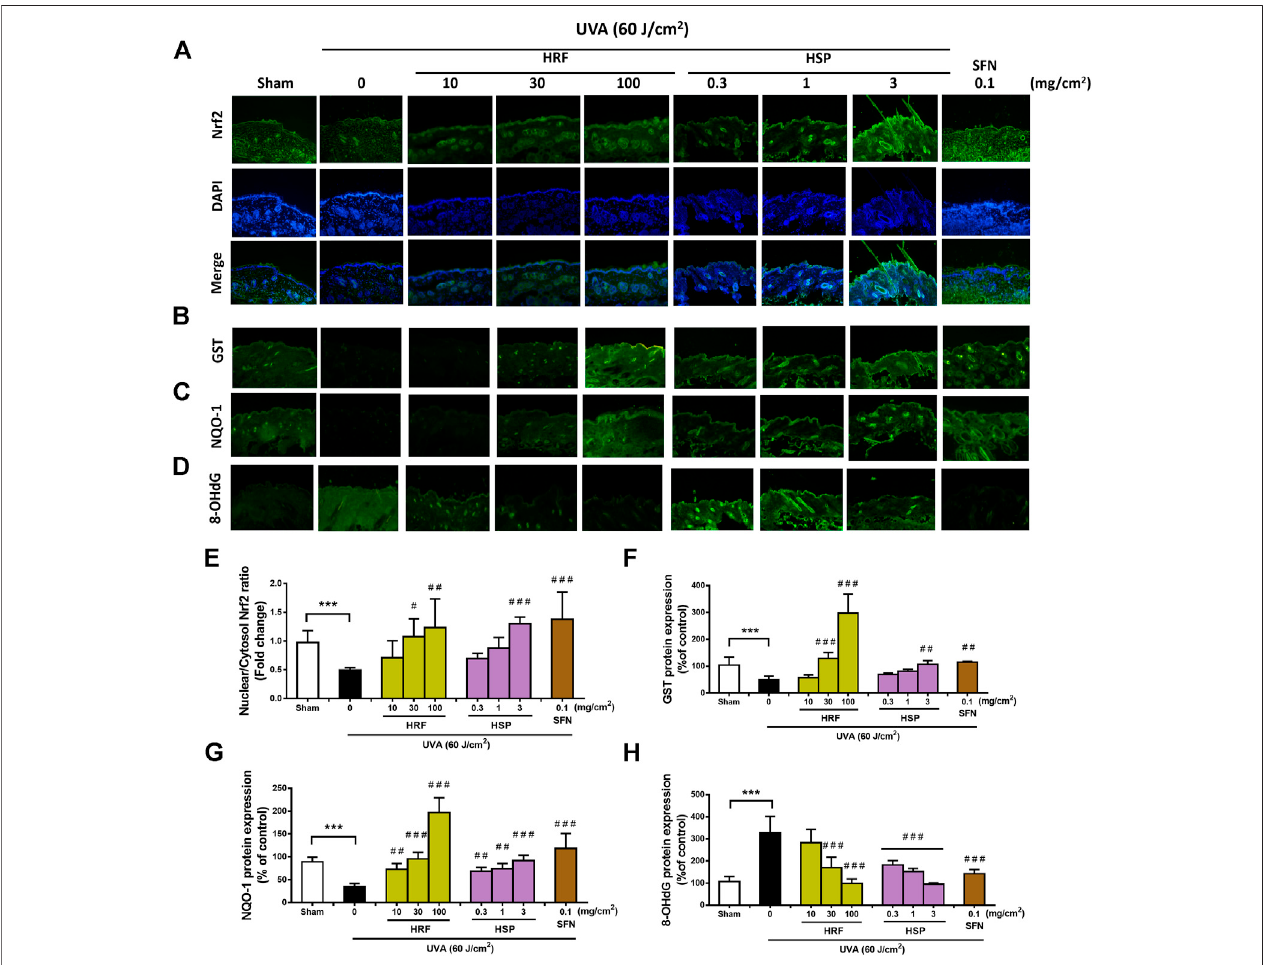
FIGURE 5 | The modulation of the Nrf2-mediated antioxidant response by HRF and HSP in mouse dorsal skin irradiated with UVA. Dorsal skin was treated with compounds as previously describes and harvested at 1 h following the fi nal irradiation. Images of immuno fl uorescence staining (FITC-conjugated secondary antibody staining indicated the location of Nrf2 (green by the anti-Nrf2 antibody. DAPI staining indicated the location of the nucleus (blue) and the merged image indicated the nuclear localization of Nrf2 (A) . The summary graph with the statistical analysis of the nuclear-to-cytosolic Nrf2 ratio (E) was quanti fi ed by ImageJ and GraphPad prismsoftwareandwasexpressedasmean ± SD, n (cid:1) 4.Theimmuno fl uorescenceofantioxidantproteinsincludingGST (B) ,NQO-1 (C) ,andtheoxidativeDNAdamage 8-OHdG (D) , were collected at 6 h following the fi nal UVA exposure. The summary graph with the statistical analysis of the protein levels of GST (F) , NQO-1 (G) , and 8- OHdG (H) werequanti fi edbyImageJand GraphPadprismsoftware andwere expressed asmean ± SD, n (cid:1) 4.*** p < 0.001vs. non-irradiated shamgroup byStudent ’ s t -test. #p < 0.05; ## p < 0.01; ### p < 0.001 vs. the sham-irradiated group by one-way ANOVA Dunnett ’ s test.